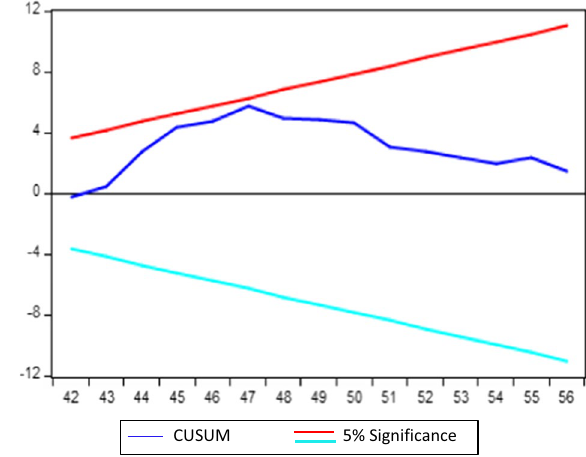
Fig. 13 Plot of cumulative sum of recursive residuals (CUSUM)